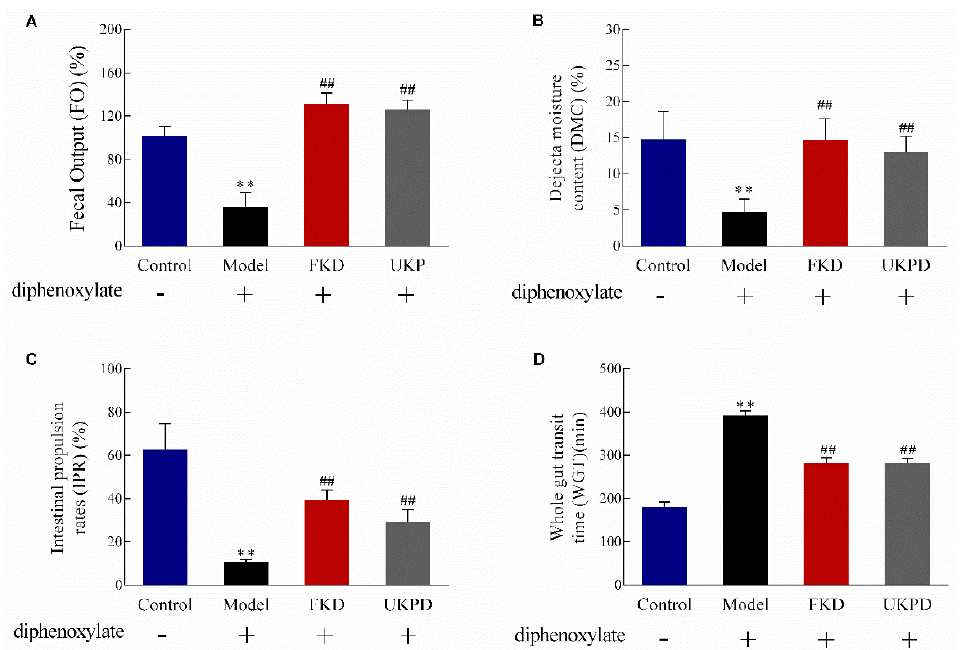
Figure 2. E ff ect of ultra-micro kiwifruit powder (UKP) and freeze-dried kiwifruit (FKD) on ( A )